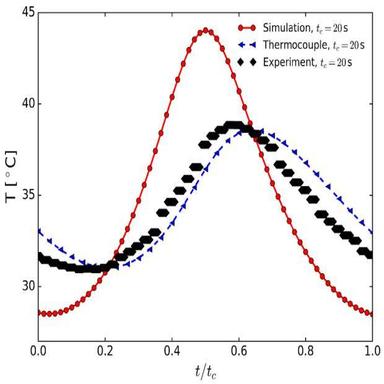
Solid temperature profile for a CO2 run in the packed bed. The solid line shows the simulated temperature in the solid phase while the dashed line shows the thermocouple temperature calculated from Eq.. Conditions: T0 = 30 C; u ¼ 0; Stroke1 = Stroke2 = 0–100 mm; tc = 20 s.